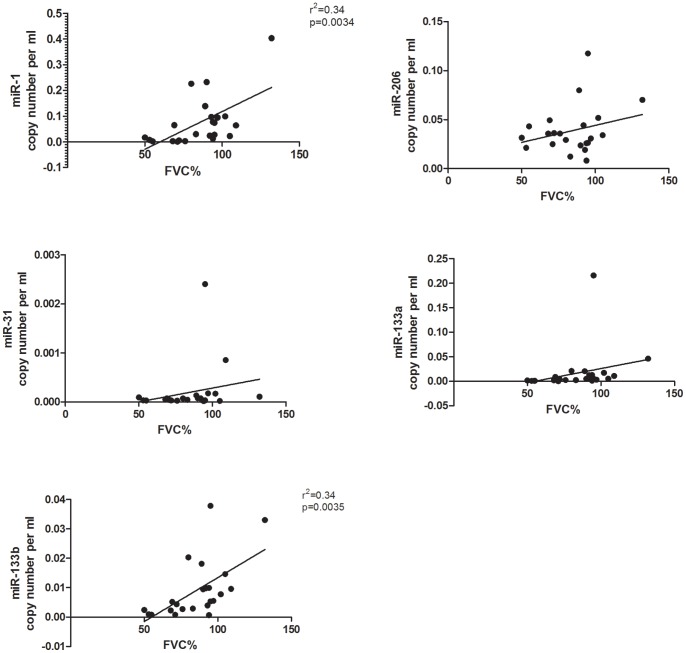
Correlation analysis between the level of the analysed dystromirs in DMD and the FVC values.Linear regression analysis between the levels of miR-1, miR-206, miR-31, miR-133a and miR-133b in serum samples and FVC scores in DMD patients showed correlation between the level of miR-1 (p = 0.0034, r2 = 0.34) and miR-133b (p = 0.0035, r2 = 0.34) with the FVC scores. The data are presented as miRNA copy number per ml normalized to the spiked-in C. elegance miRNA s (cel-miR-54, cel-miR-39, cel-miR-238). Regression lines are also presented.